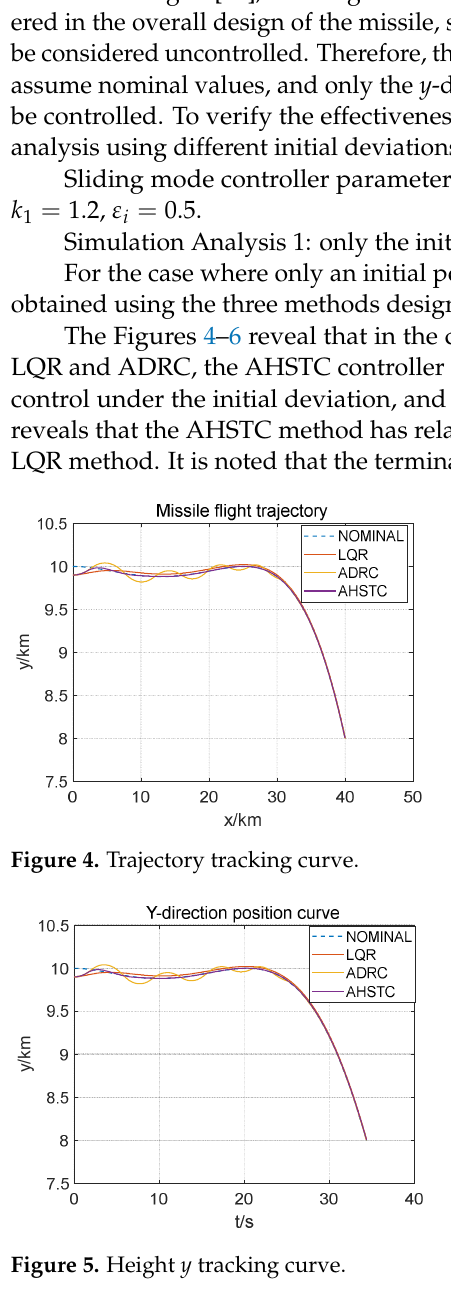
Figure 6. Control tracking curve. The Figures 4−6 reveal that in the case of an initial position deviation, compared to LQR and ADRC, the AHSTC controller designed in this paper can achieve good tracking control under the initial deviation, and the control accuracy is high. In addition, Table 2 reveals that the AHSTC method has relatively small terminal state error, compared to the LQR method. It is noted that the terminal state y and θ are measured by all-state sensors.